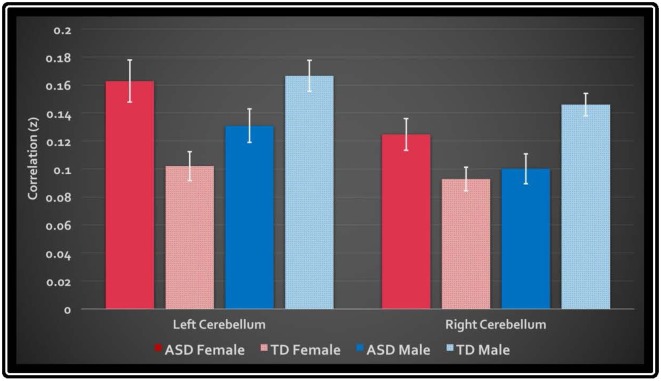
Mean global connectedness values for left and right cerebellar clusters. The y-axis displays the average z-transformed correlation coefficient of the cluster’s mask with every other voxel in the brain. White bars denote standard error.